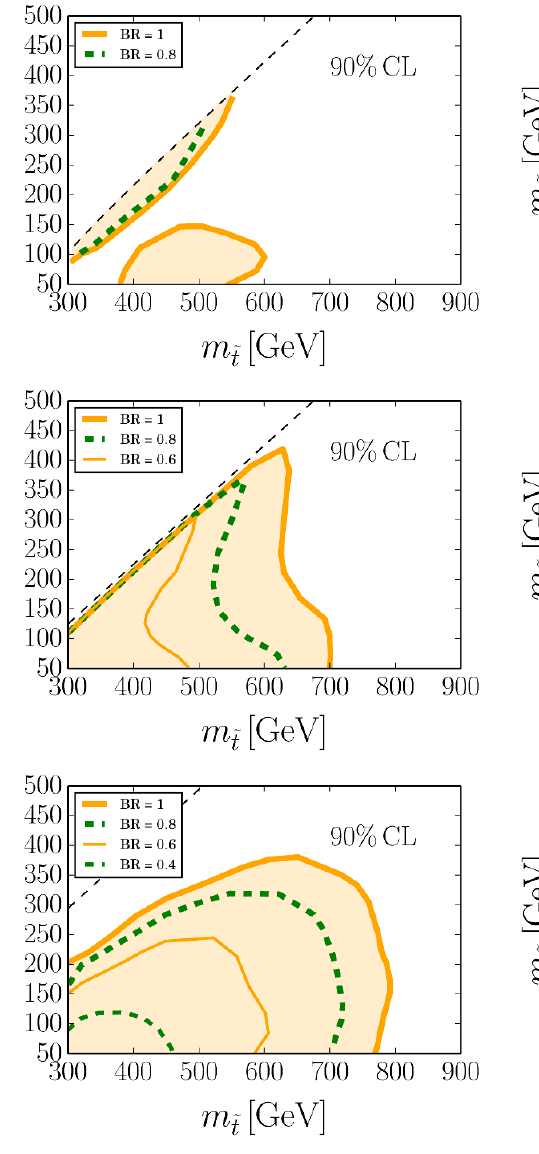
Figure 3 . Upper panels: excluded region for BR( e t ! t (cid:28)(cid:28) ) = 1 ; 0 : 8 at the 90% CL (left panel) and e 95% CL (right panel) in the plane ( m ; m ). For each value of the branching ratio the excluded e t e (cid:23) region is the one enclosed by the corresponding curve. Above the thin dashed line the channel is kinematically forbidden. Middle panels: the same for BR( e t ! t (cid:23)(cid:23) ) = 1 ; 0 : 8 ; 0 : 6. Lower panels: the e same for BR( e t ! b (cid:23)(cid:28) ) = 1 ; 0 : 8 ; 0 : 6 ; 0 : 4. e